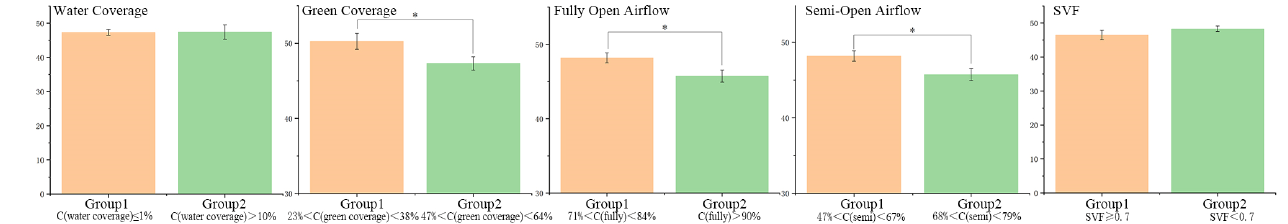
Figure 7. One-way analysis of variance (ANOVA) of humidity and greenspace elements. * p < 0.05.